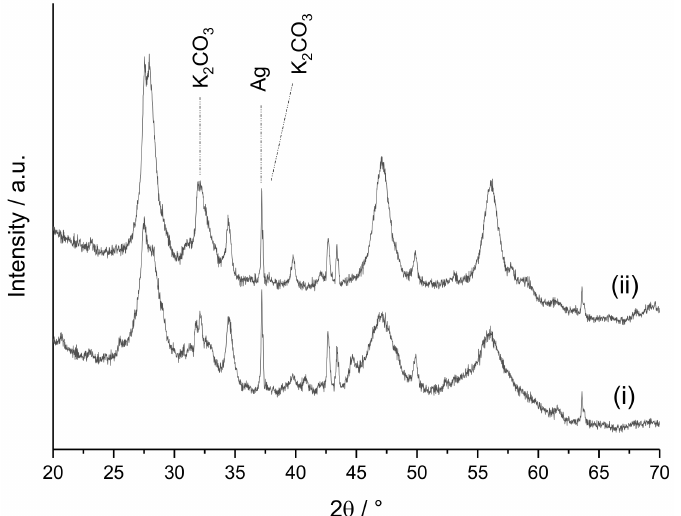
Figure 4. Full-range scan diffraction pattern for 2%Ag–20%K/CZA (i) before and (ii) after temperature-programmed XRD analysis.